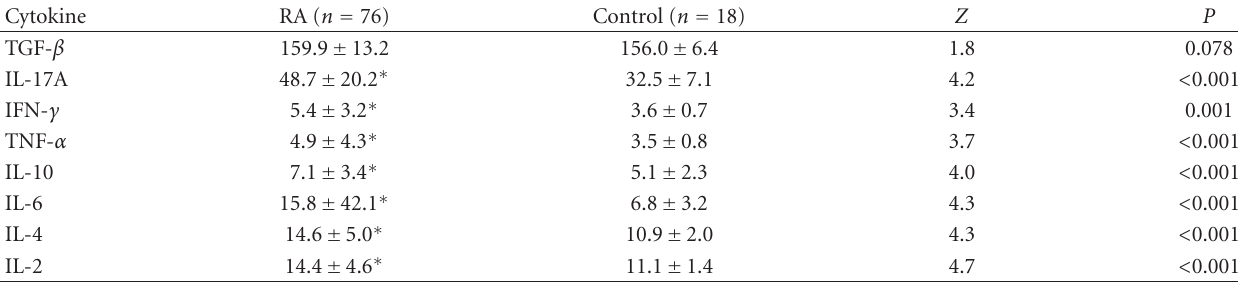
Table 2: Th cell-related cytokine changes of RA patients compared with healthy